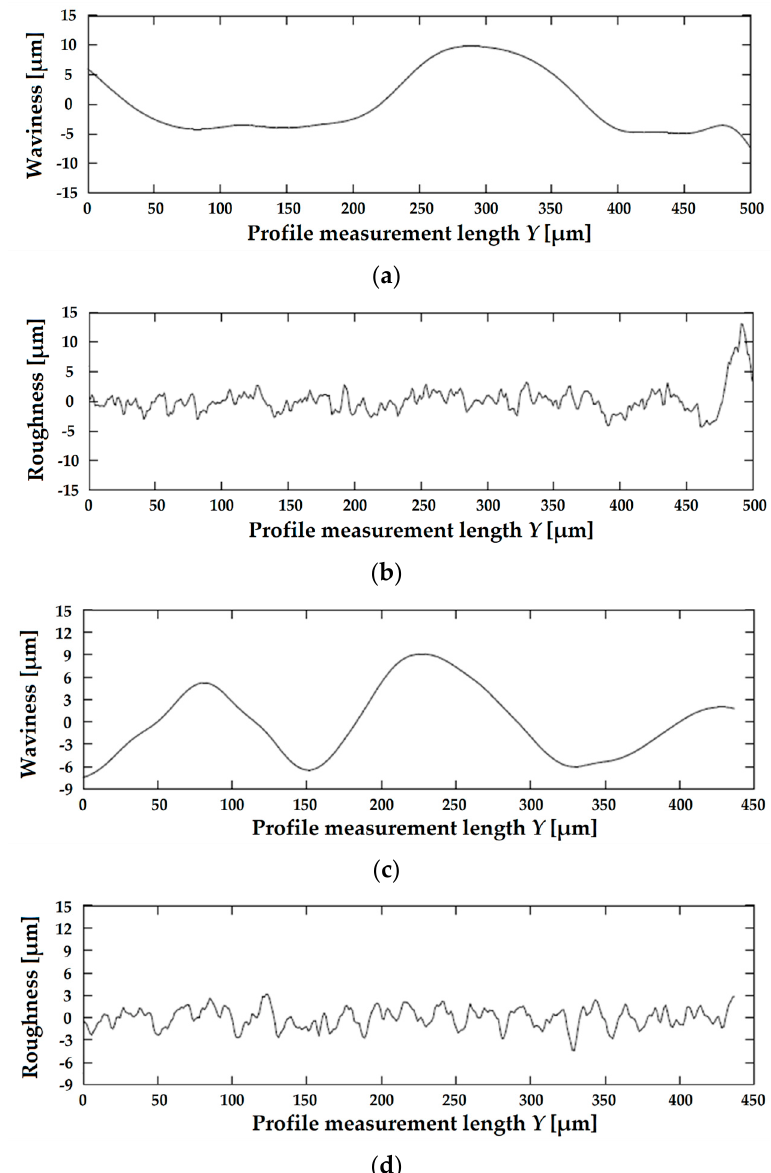
Figure 12. Transverse waviness and roughness profile after Gaussian regression (profilometry): ( a ) waviness after laser powder bed fusion method; ( b ) roughness profile after laser powder bed fusion method; ( c ) waviness after vibratory tumbling; ( d ) roughness profile after vibratory tumbling.